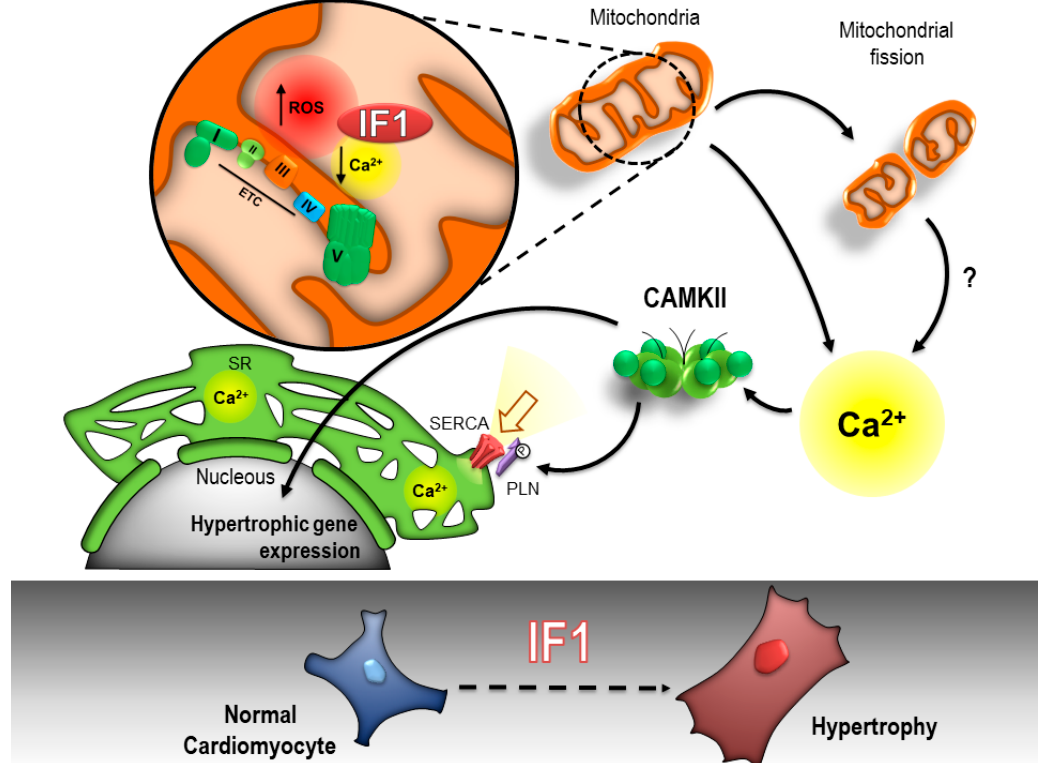
Figure 7. Schematic representation of the proposed mechanism responsible for IF1-mediated cardiomyocyte hypertrophy. Under conditions of respiratory collapse, ATPase inhibitory factor-1 (IF1) prevents maladaptive ATP hydrolysis by ATP synthase (complex V). The function of IF1 under normal respiring conditions remains poorly described. We present evidence for a novel, ATP-synthase-independent, role for IF1 in mitochondrial calcium handling and mitochondri- al-to-nuclear crosstalk involving calcium–calmodulin kinase II (CaMKII). Specifically, we found that IF1 induced mito-